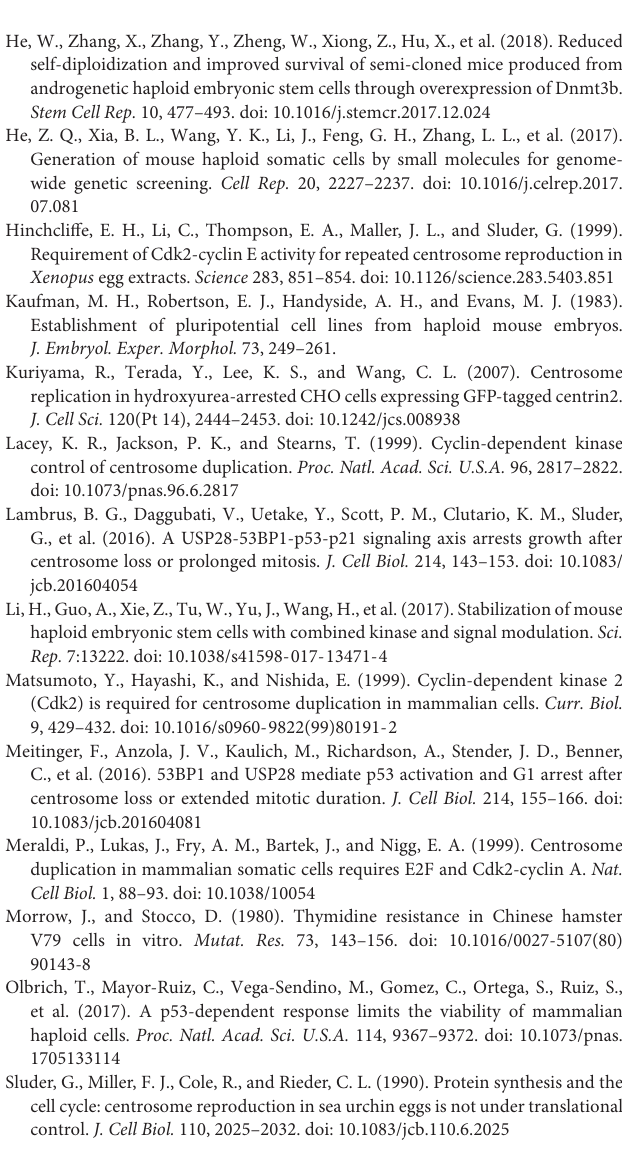
FIGURE S1 | Intermittent extension of DNA replication cycle by cell cycle inhibitor treatment/release. (A) Experimental scheme of inhibitor treatment/release cycles. (B,C) Flow cytometric analysis of DNA content in Hoechst-stained haploid cells in inhibitors treatment/release cycles. Histograms of Hoechst signal and dot plots of forward scatter signal (for the judgment of relative cell size) against the Hoechst signal are shown in panels (B,C) , respectively. Representative data from three independent experiments. Note that co-treatment of roscovitine did not change the profile of cell cycle arrest/release in the thymidine treatment/release cycle. (D,E) Timecourse flow cytometric analysis of DNA content (Hoechst signal; D,E ) and PI incorporation (E) in haploid cells after the first washout of thymidine. (F) Proportions of PI-positive cells or sub-G1 population in panel (E) . Means ± SE of three independent experiments ( ∗ p < 0.05, two-tailed t